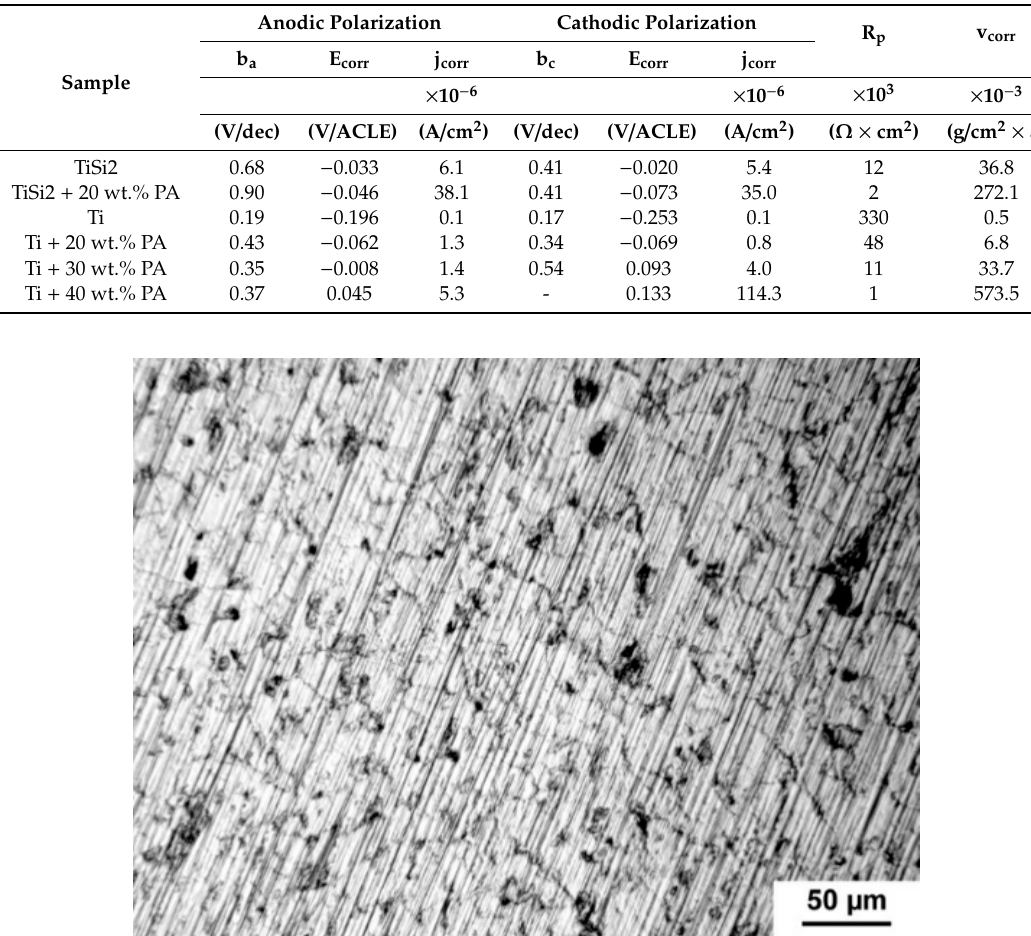
Figure 11. Intergranular corrosion of TiSi2 alloy.